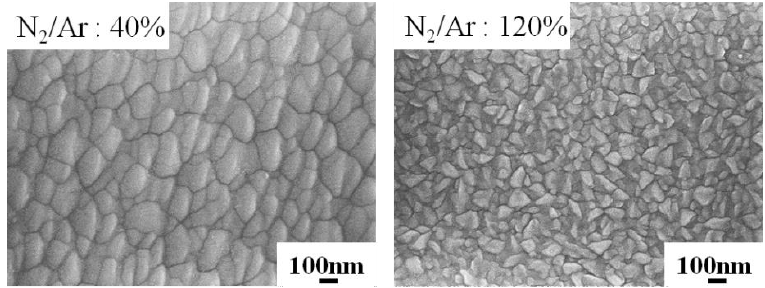
Figure 5. SEM images of CrAlN layers formed under N 2 /Ar flow ratios of 40% and 120%. Table 3. Mechanical properties of CrAlN coatings under various N 2 /Ar flow